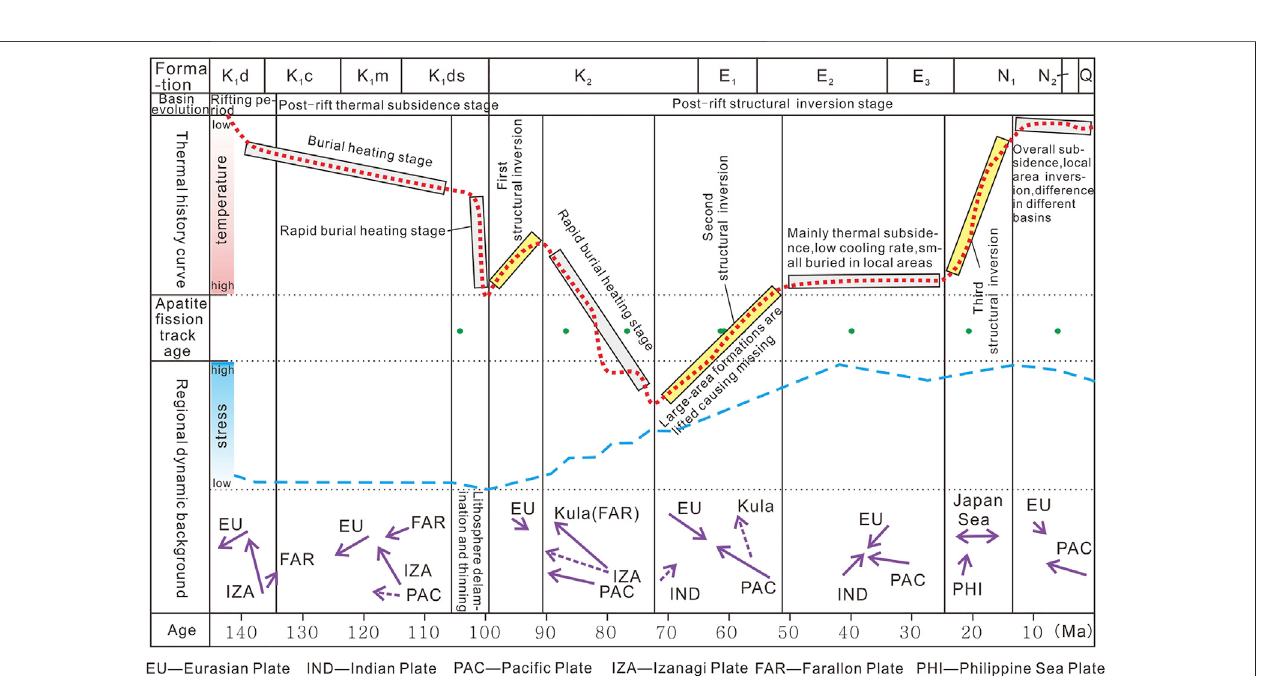
Frontiers in Earth Science |